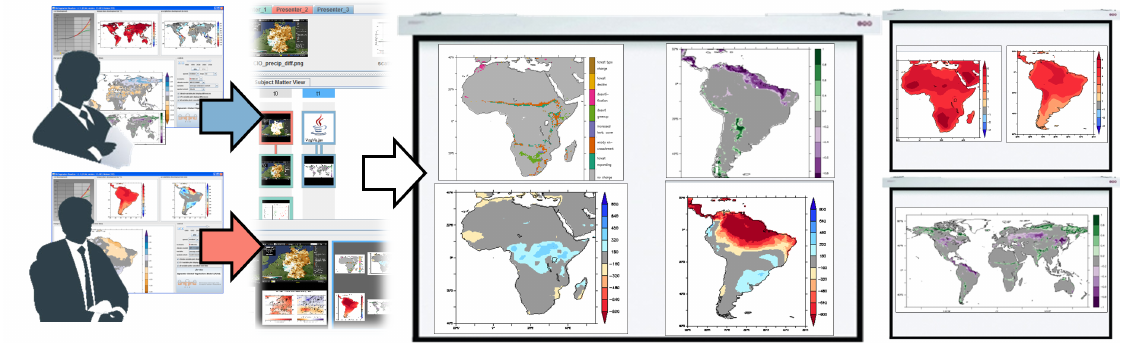
Figure 6. The forestry expert provides a slide of the worldwide risks and starts the Vegetation Visualizer tool to generate further views of Africa and South America. The hydrologist joins in by starting his own instance of the same tool. The on-the-fly generated views from both experts are simultaneously